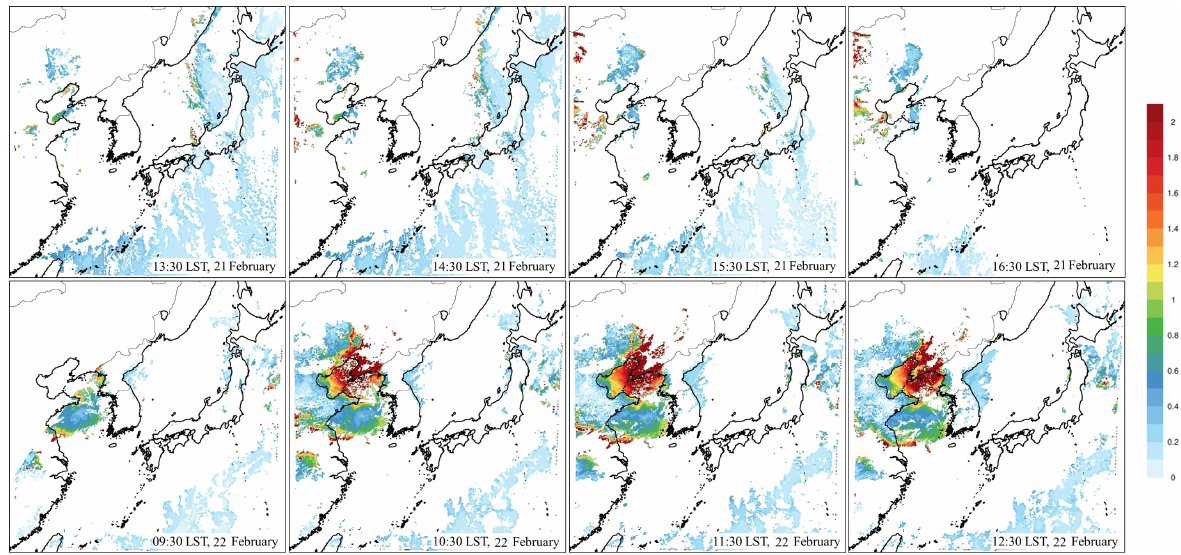
Figure 7. The GOCI-derived AOD (550nm) from 13:30LST on 21 February to 12:30LST on 22 February 2015. The white-colored areas represent missing